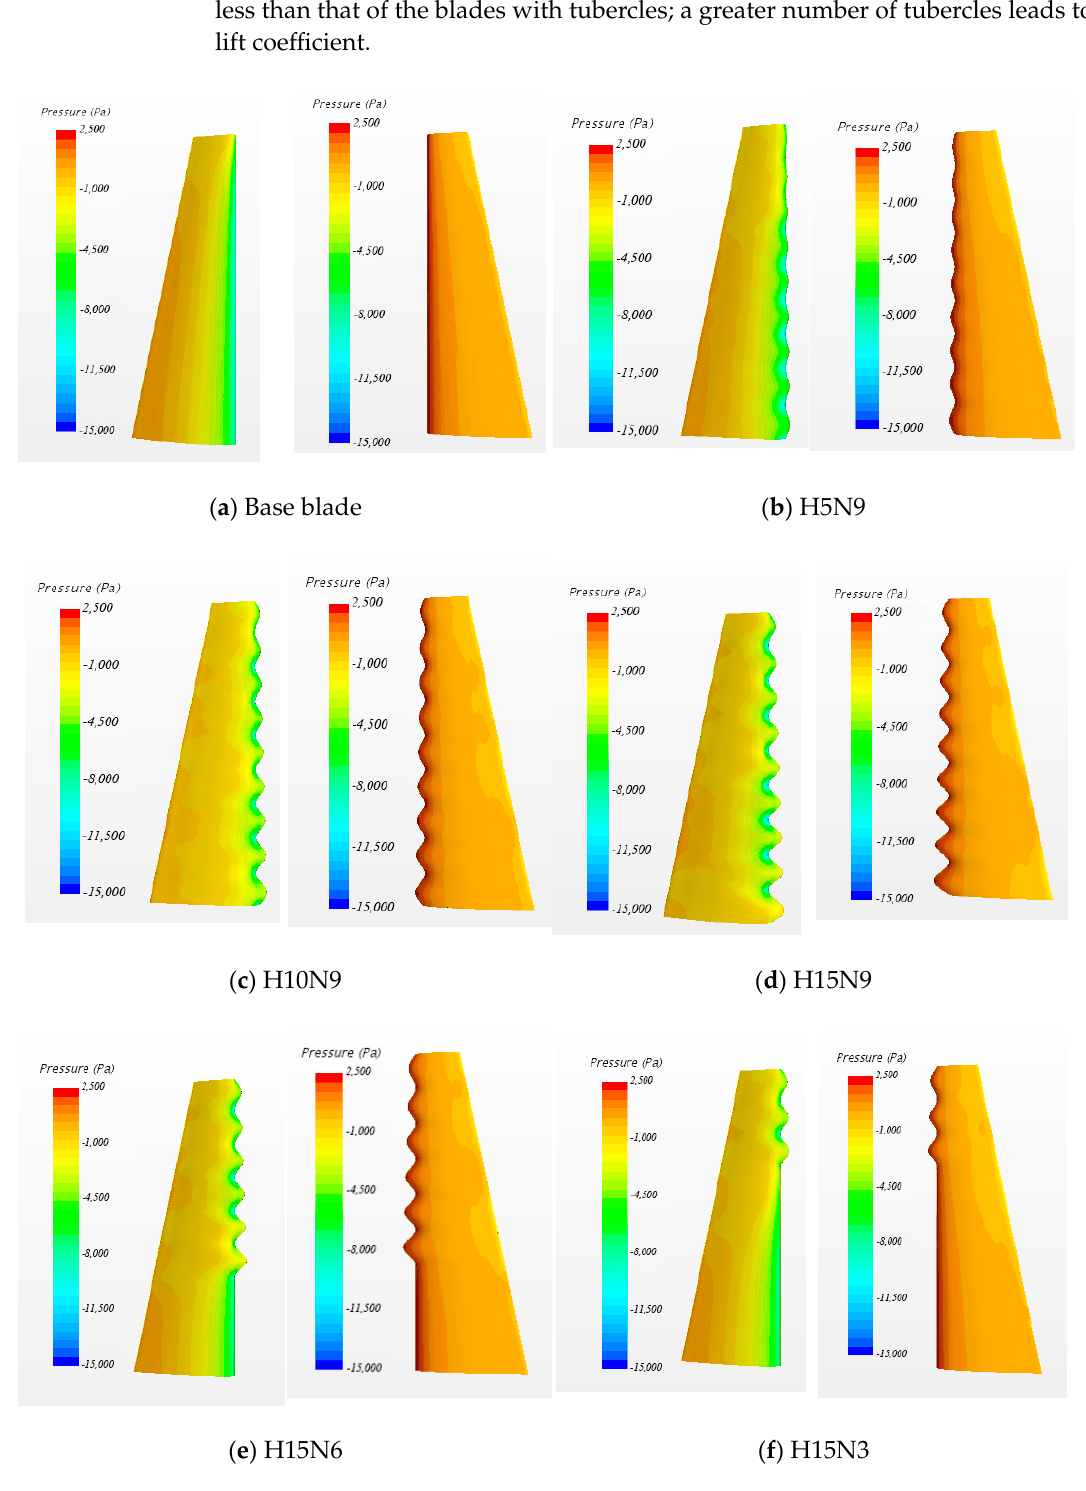
Figure 18. Relative pressure distributions on the upper (left) and lower (right) surfaces of ( a ) base blade, ( b ) H5N9, ( c ) H10N9, ( d ) H15N9, ( e ) H15N6 and ( f ) H15N3 when attack angle is 16°.